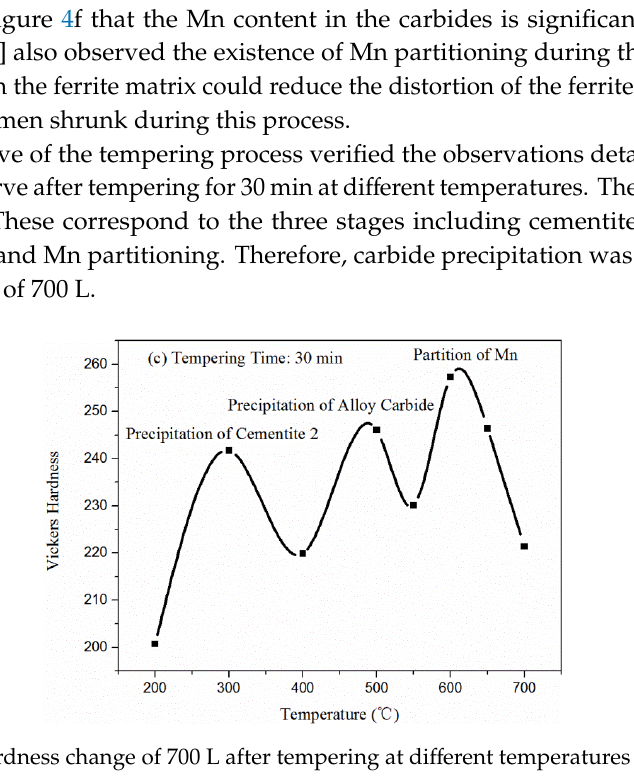
Figure 4. TEM images during tempering at different temperatures. ( a ) TEM image before tempering; ( b )TEM image at 200 °C—precipitation of cementite I; ( c ) TEM image at 300 °C—decomposition of retained austenite; ( d ) TEM image at 300 °C—precipitation of cementite II; ( e ) TEM image at 550 °C—alloy carbide precipitation; ( f ) TEM image at 650 °C—Mn partitioning.